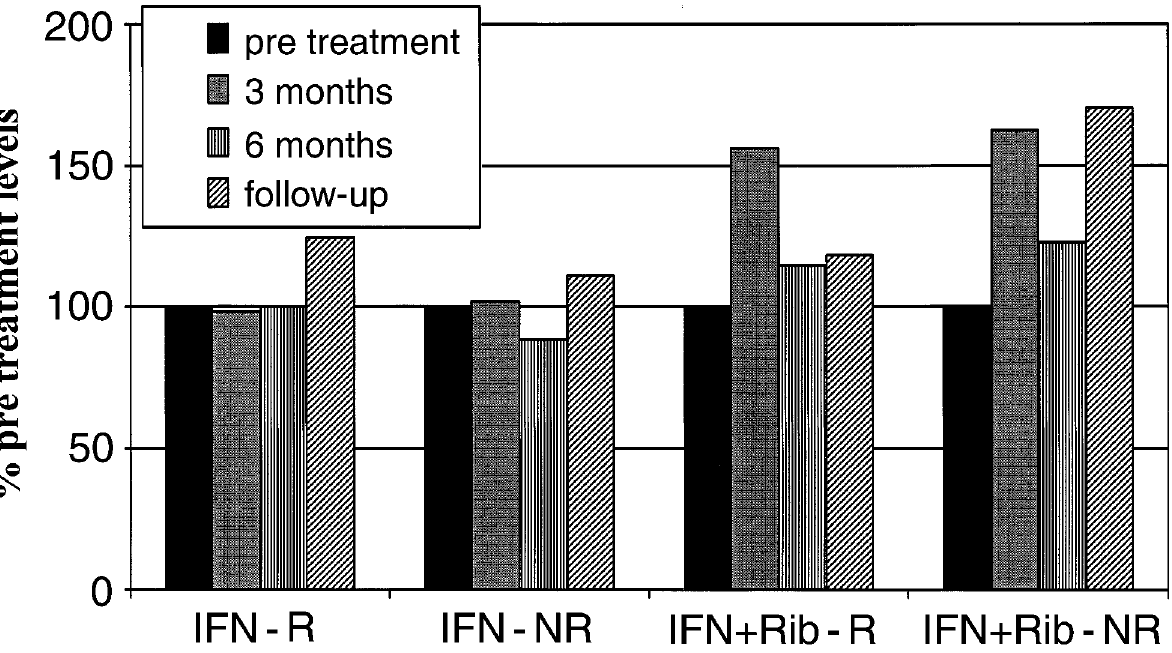
FIG. 2. VCAM-1 levels in responders (R) and non-responders (NR) to both IFN monotherapy (IFN) and IFN + ribavarin combination therapy (IFN + Rib). Results are expressed as percent of pre-treatment levels (pre-treatment levels =